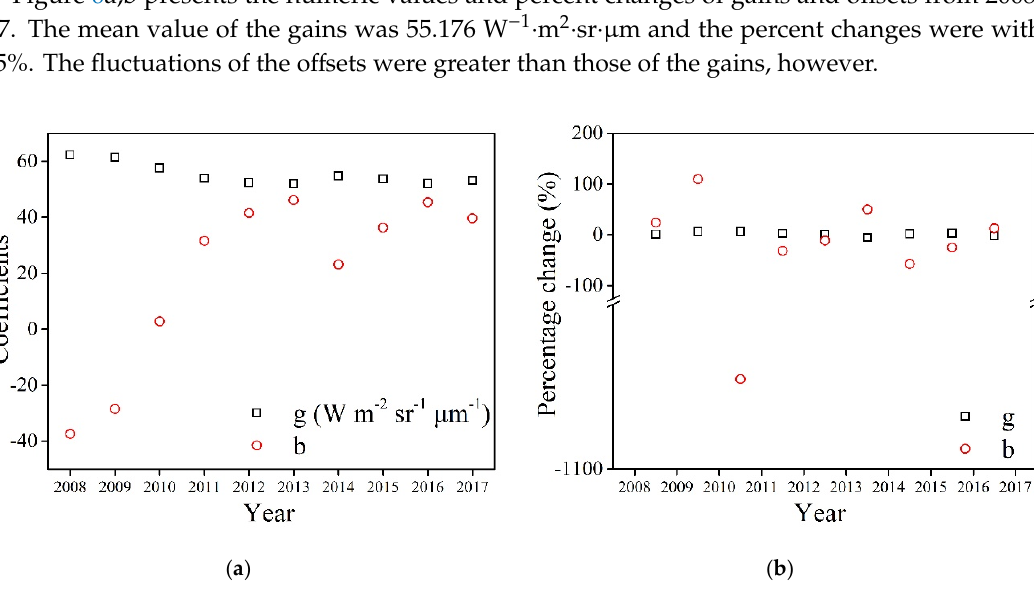
ff sets in di ff erent years. ( a ) Numeric values; ( b ) percent Figure 6. Gains and offsets in different years. ( a ) Numeric values; ( b ) percent changes. Figure 6. Gains and o